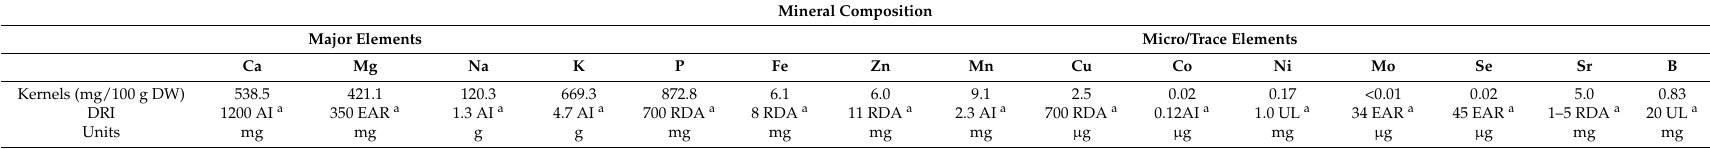
Table 3. Major and trace elements composition of Terminalia ferdinandiana kernels (mg/100 g DW).